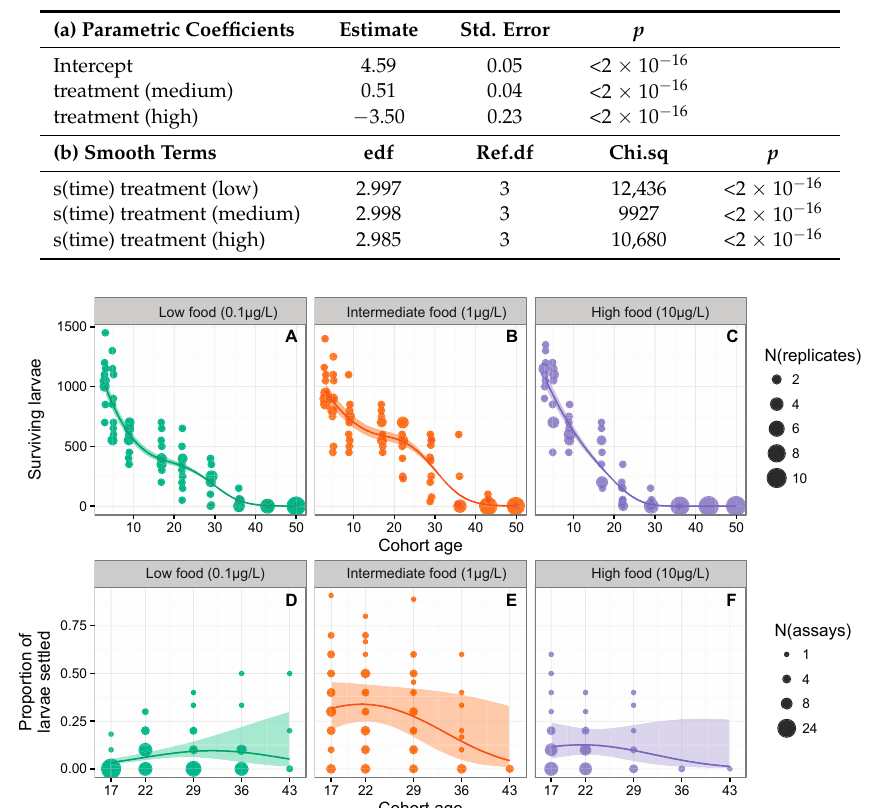
Table 1. Estimates of the ( a ) parametric coefficients and ( b ) the approximate significance of the smooth terms of the survival model (Poisson error distribution, log link functions). Parametric intercept term represents the low food treatment.